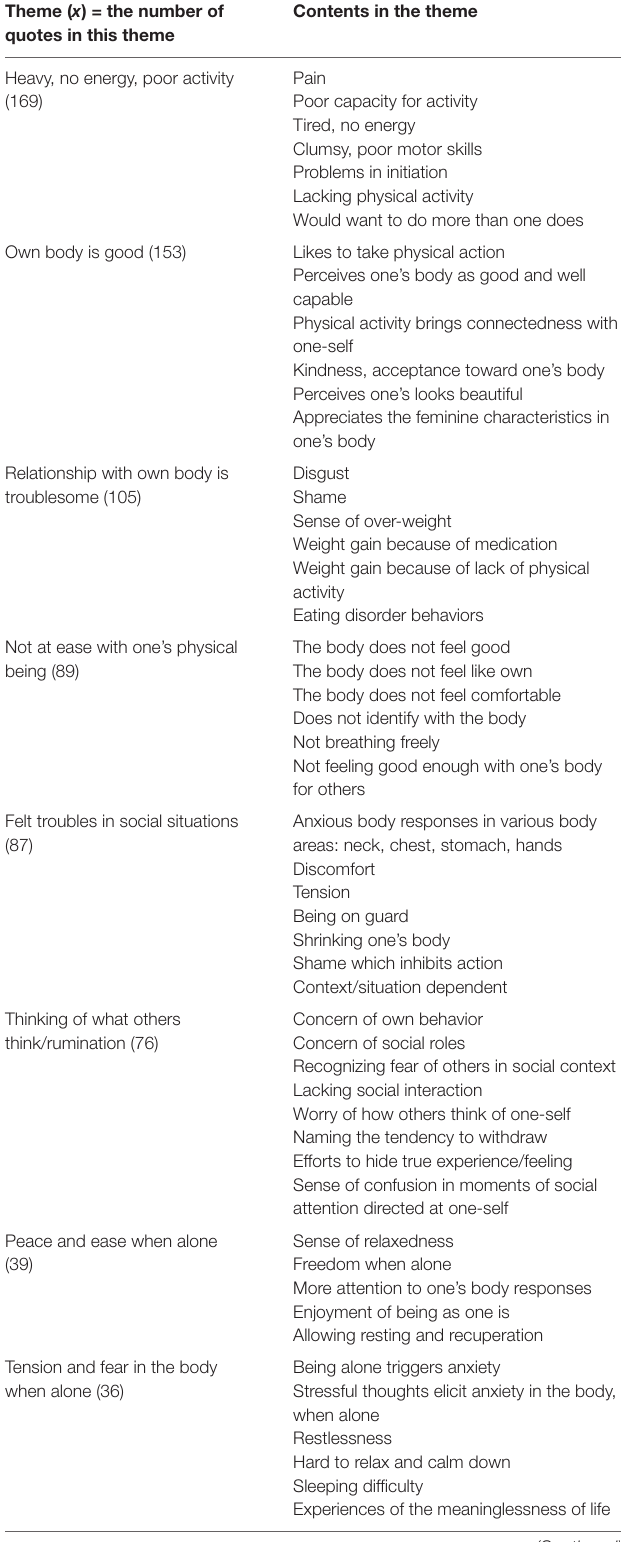
TABLE 1 | Themes in the Body Image Assessment (BIA) of patients with depression at the pre-intervention measurement, in order of frequency. Theme ( x ) = the number of quotes in this